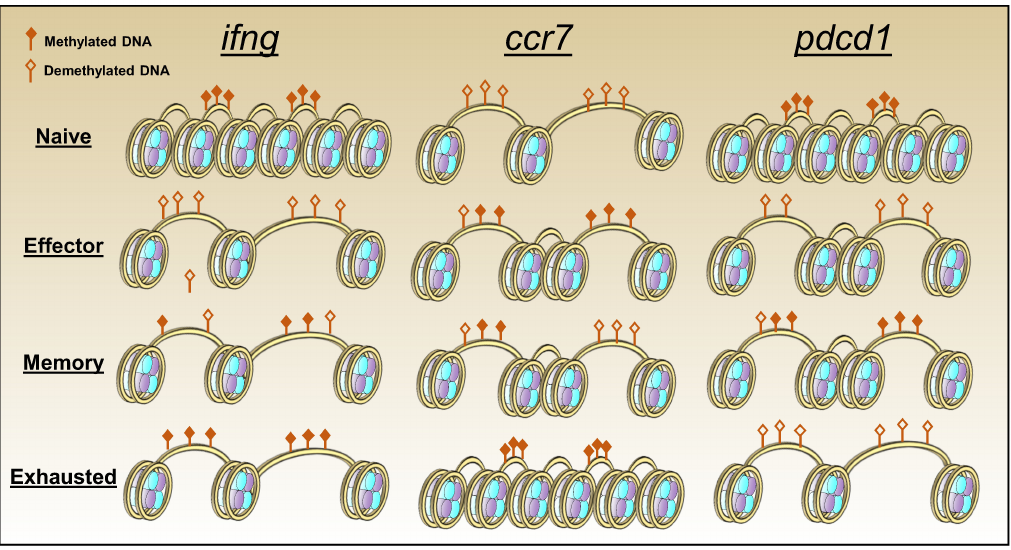
Figure 3. CD8 T cell exhaustion is characterized by a unique pattern of chromatin accessibility and DNA methylation. Over the course of CD8 T cell differentiation, effector associated (ifn g), memory-associated ( ccr7 ) and exhaustion-associated genes ( pdcd1 ) undergo unique shifts in chromatin accessibility which impact the availability of transcription factor binding sites and the ability of each gene to be transcribed. Notably, in exhausted cells the ifn g locus remains epigenetically open but undergoes de novo methylation. Conversely, the pdcd1 locus remains demeythylated and actively expressed in exhausted CD8 T